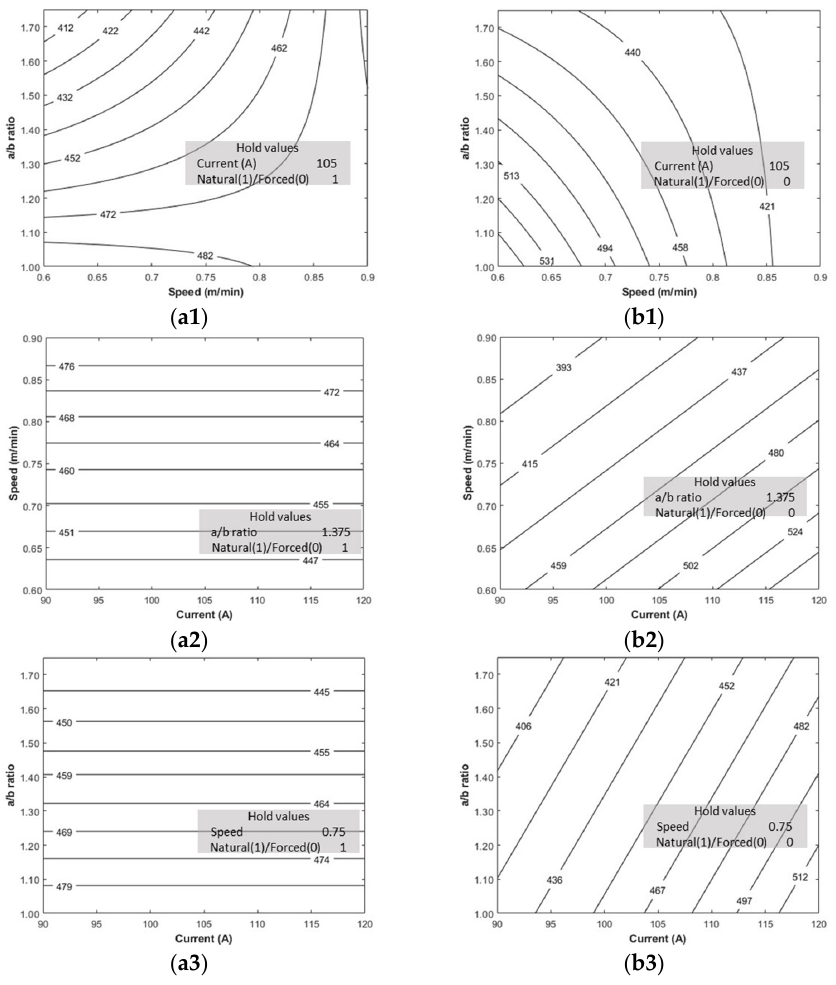
Figure 11. Contour plots for residual stress, ( a1 – a3 ) forced cooling, ( b1 – b3 ) natural cooling. The welding current in fl uences the residual stress when forced cooling is applied (Figure 11(a2,a3)). The residual stresses increase with the increase in current because of increased heat input. The current’s e ff ect, within the range of experiments, does not ap- pear with the natural cooling (Figure 11(b2,b3)) because the heat dissipates slowly. The residual stress is impacted by active thermal management. Compared to passive management, the range of residual stress over the plate shrinks (Figure 10). The stresses are uniformly distributed. The average maximum residual stress comes down by 100 be- cause of passive management. The residual stress is minimum for the insulated–heated substrate (case A1) compared to others. The preheating may result in stress relieving of the original plate; additionally, as the deposition is performed in the heated condition, the thermal gradients are remarkably reduced. 4.3. Hardness Variation with Passive and Active Thermal Management As additive manufacturing is a process in which the component is gradually fabri- cated, the deposition sequence is also a parameter to be factored in. To understand how the sequence of steps a ff ects the properties of the fabricated component, the hardness var- iation across the cross-section for three samples (P1, P3, P16) from the above set, indicative of a di ff erent rate of cooling, was carried out. Hardness was measured across the height